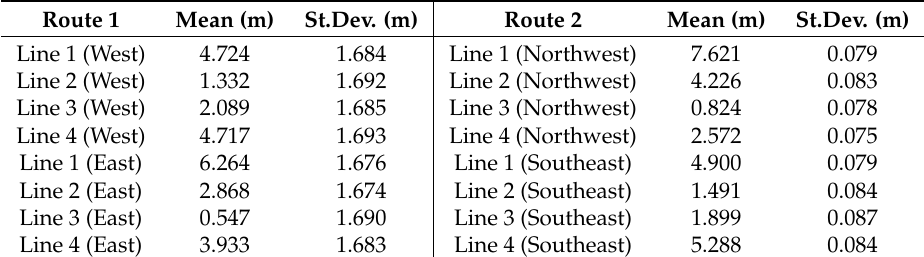
Table 1. Consistency evaluation with the commercial road-level map